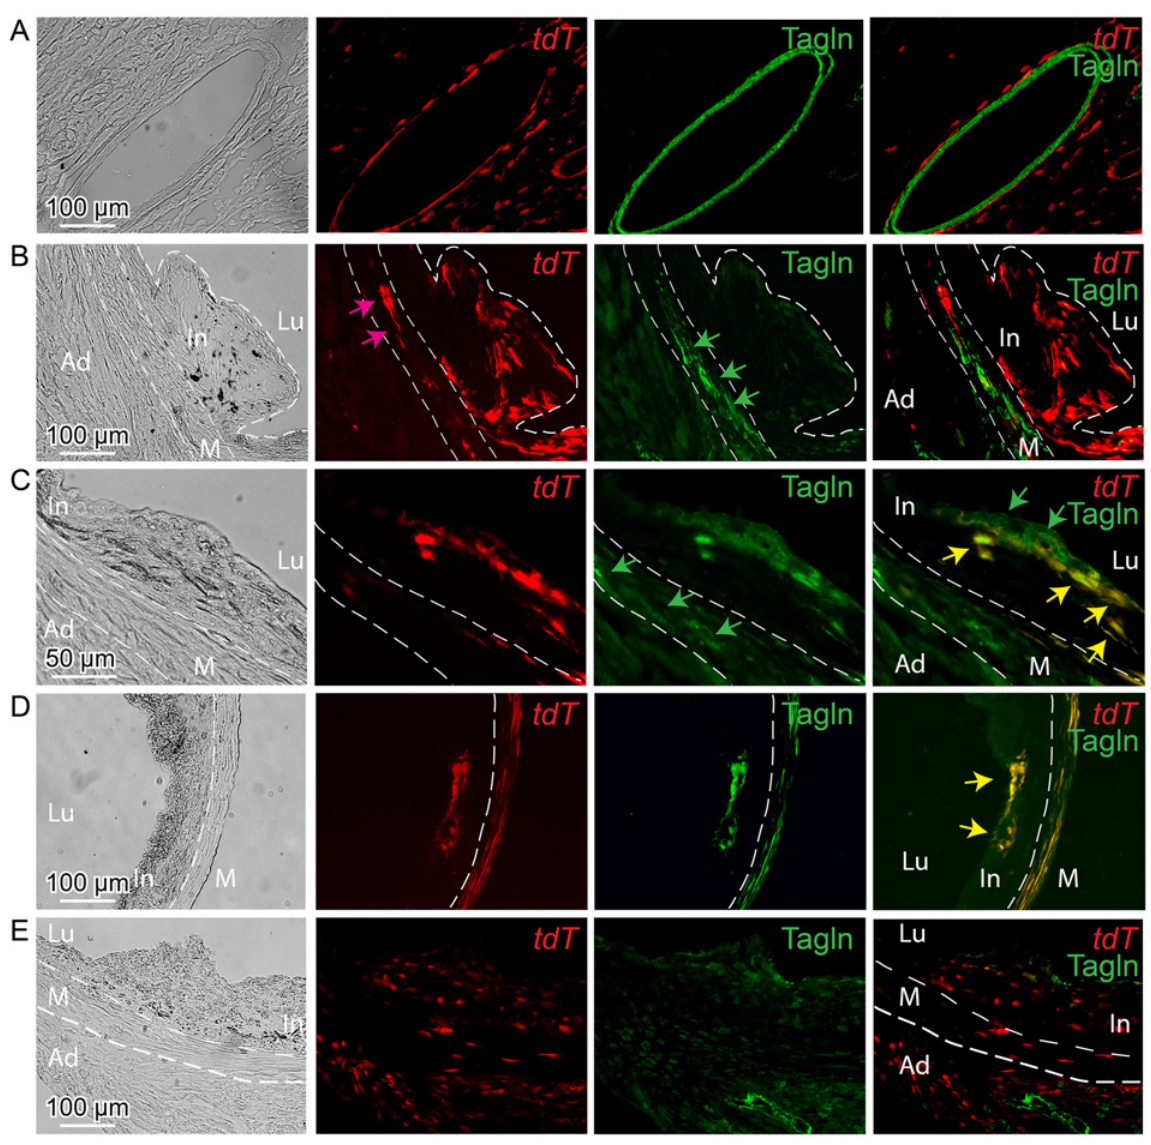
Fig 5. Tcf21 expressing cells in ApoE -/- lesions give rise to smooth muscle cells in the fibrous cap. Tcf21 iCre/+ , ApoE -/- mice were administered tamoxifen to activate expression of an inducible MerCreMer construct knocked into the Tcf21 locus [31]. Cre mediated recombination of a tomato (tdT) reporter at the constitutively expressed ROSA26 locus allowed lineage tracing of Tcf21 expressing cells. Animals received tamoxifen at 6 – 8 weeks of HFD and tissues were harvested at 12 weeks of diet (A-D), or received tamoxifen 4 – 6 weeks of age prior to HFD and tissues harvested at 16 weeks (E). A) Intramyocardial coronary artery showing Tcf21 expression (tdT) in adventitial cells surrounding the Tagln positive medial SMC. B) In an early lesion without a defined fibrous cap, tdT positive cells were seen throughout the lesion and in the media (pink arrow), with Tagln staining (green arrows) being restricted to cells in the media. C) In the Tagln and tdT merged imaging (right panel), lesion Tagln positive cells are identified in the fibrous cap (green arrows) and some of these cells co-stain for tdT fluorescence (yellow arrows), indicating that they previously expressed Tcf21 . Tagln expressing cells in the media (green arrows, Tagln only imaging) do not colocalize with tdT staining in this location. D) Tagln positive cells in the fibrous cap were also positive for tdT fluorescence, suggesting that the identified SMC had expressed Tcf21 . Also, co-staining of tdT and Tagln is noted in the media (yellow color). E) Animals received tamoxifen at 4 weeks of age prior to HFD and tissues were harvested at 12 weeks of diet. In an early lesion without a defined fibrous cap, tdT positive cells are seen throughout the adventitia, in the media and in the plaque. In, intima; M, media; Ad, adventitia; Lu,